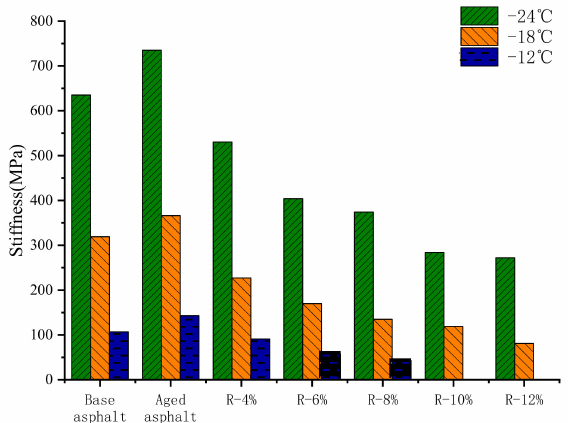
Figure 7. S of different reclaimed asphalt